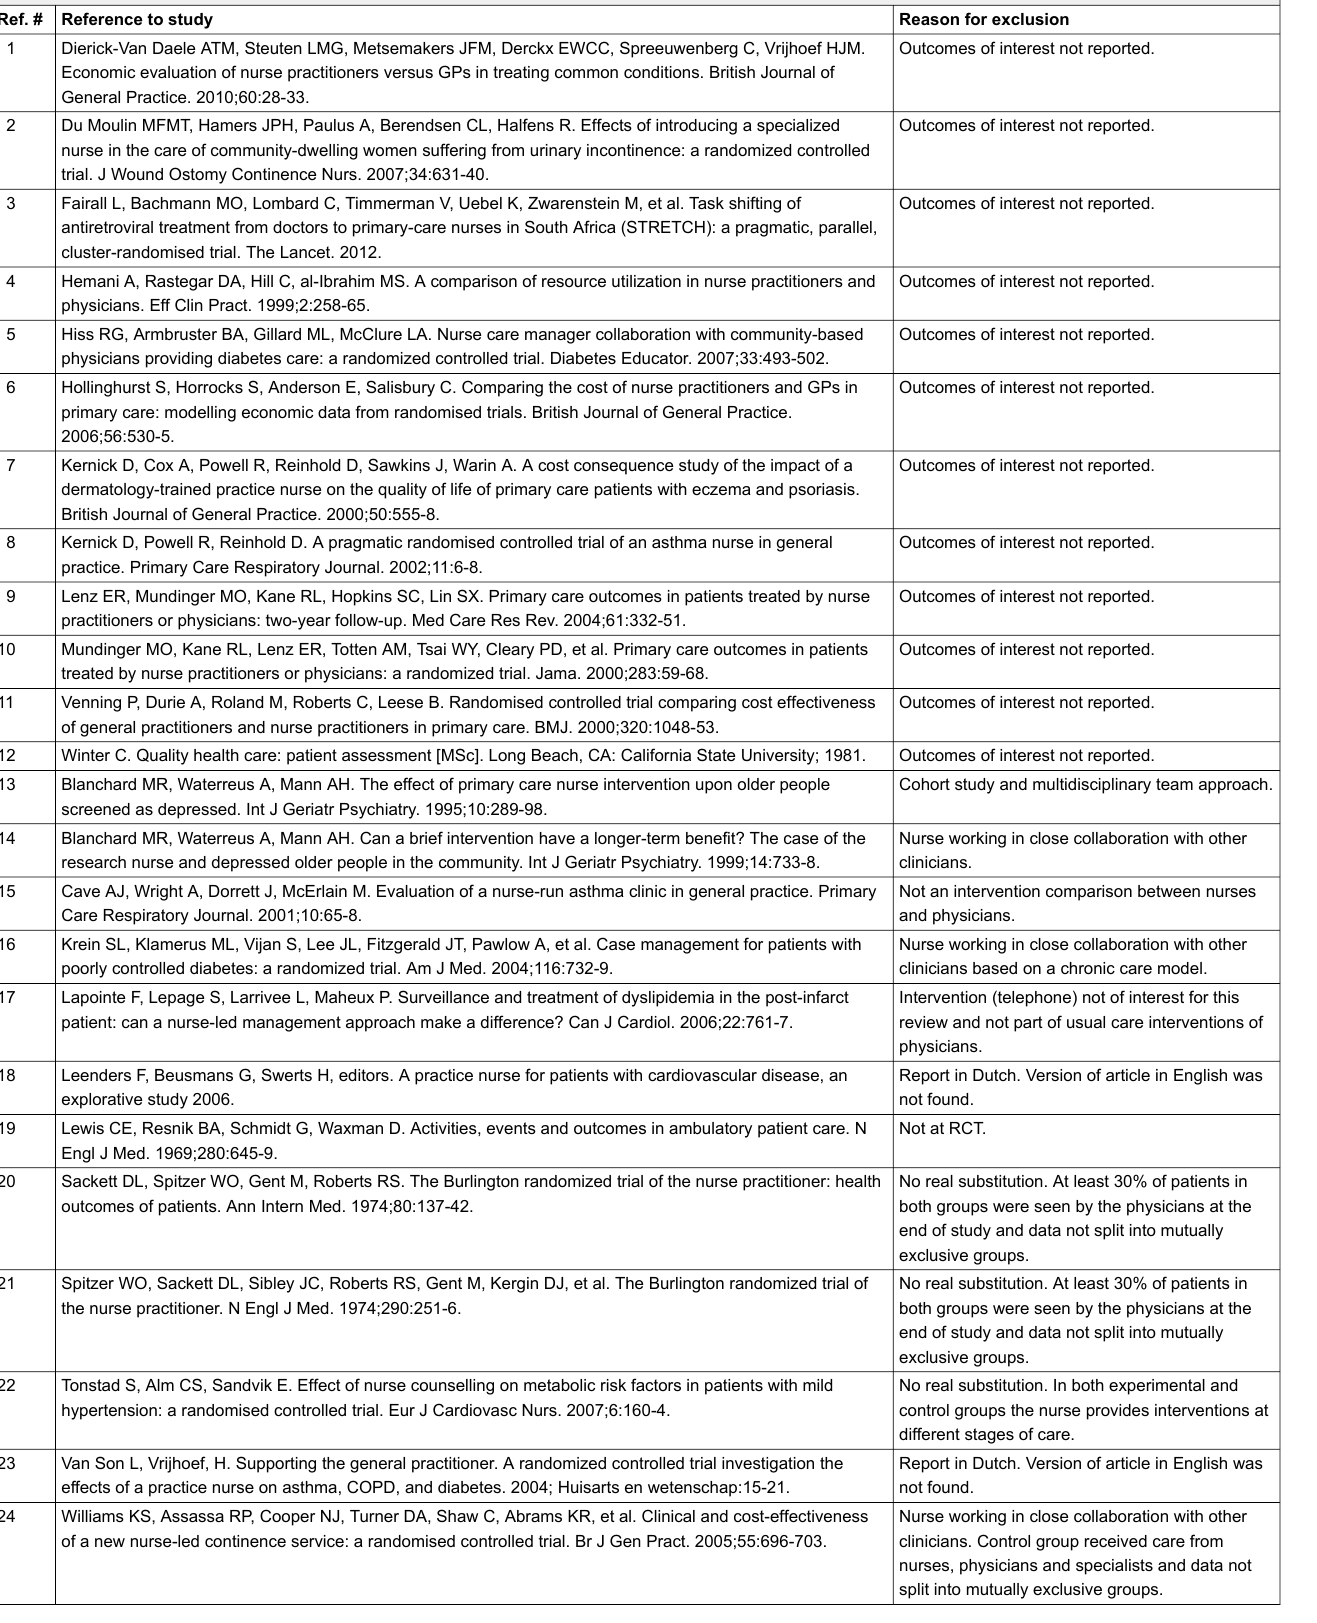
Table S3: Studies excluded with reasons for exclusion based on appraisal of full text